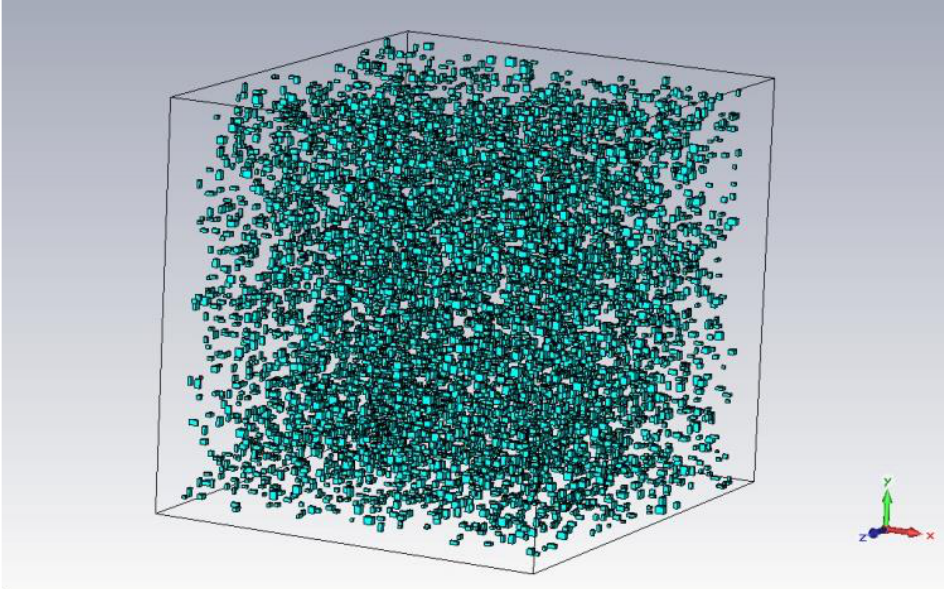
Figure 5. Simulation model with maximum number of random particles (8000).